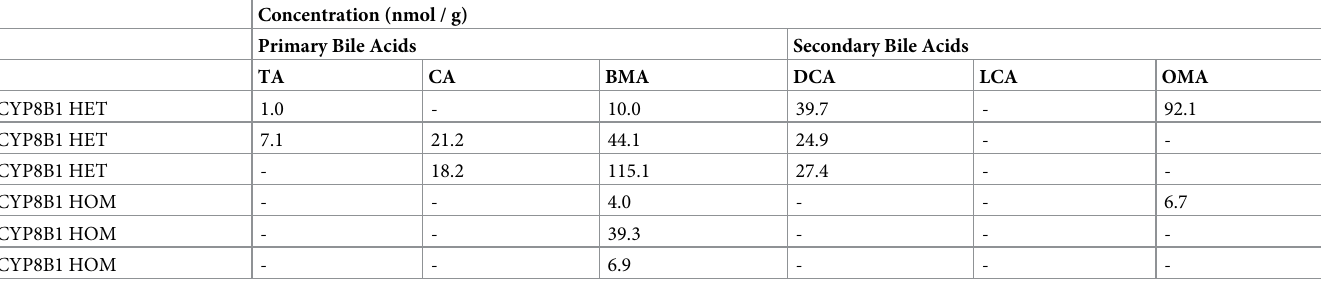
Table 2. Bile acid profiles of C . scindens colonized CYP8B1 heterozygous and CYP8B1 homozygous mice. Concentration (nmol / g)